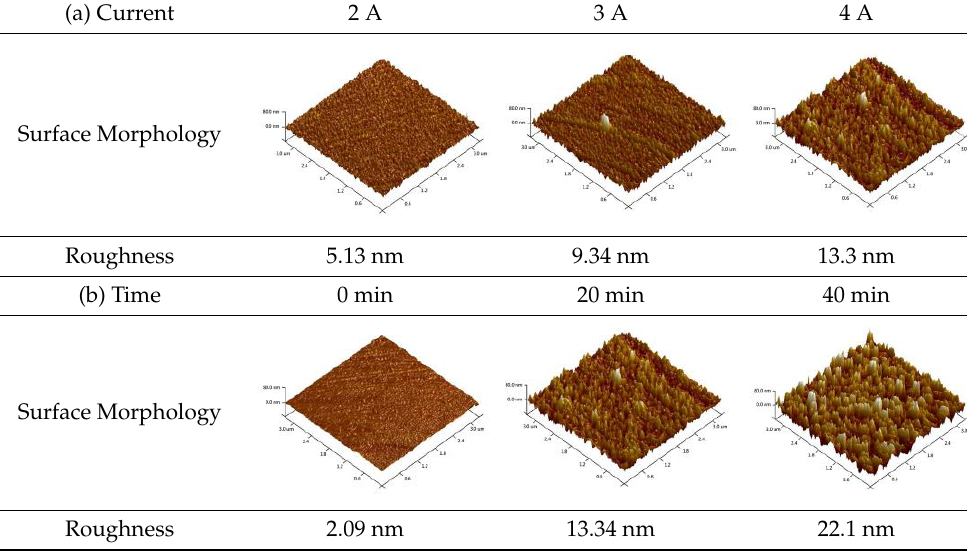
Figure 2. Roughness of PC substrates after different ion bombarding voltages. In 1936, Wenzel proposed to modify the model of Young ’ s equation to explore the wetting behavior of liquid on rough surfaces [30]: 𝑐𝑜𝑠 𝜃 𝑤 = 𝐴 𝑎𝑐𝑡 𝐴 𝑝𝑟𝑜 × 𝛾 𝑆𝐺 − 𝛾 𝑆𝐿 𝛾 𝐿𝐺